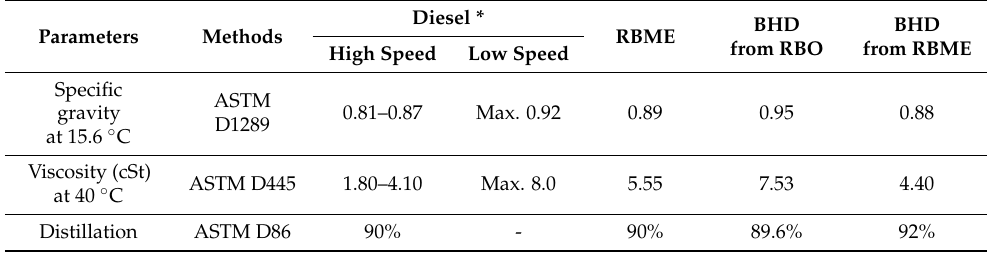
Table 3. Characterisation of biodiesel (RBME) and BHD from RBO/RBME.